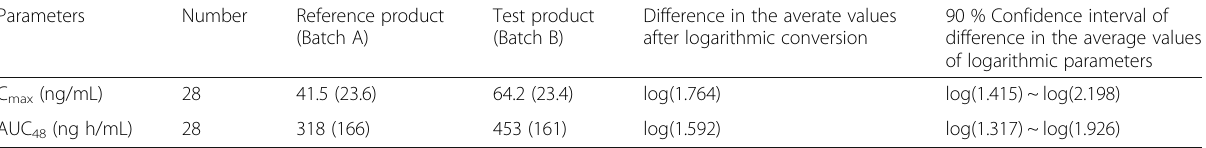
Table 5 Pharmacokinetic parameters of itraconazole in plasma and 90 % confidence interval of difference in the average values of logarithmic parameters